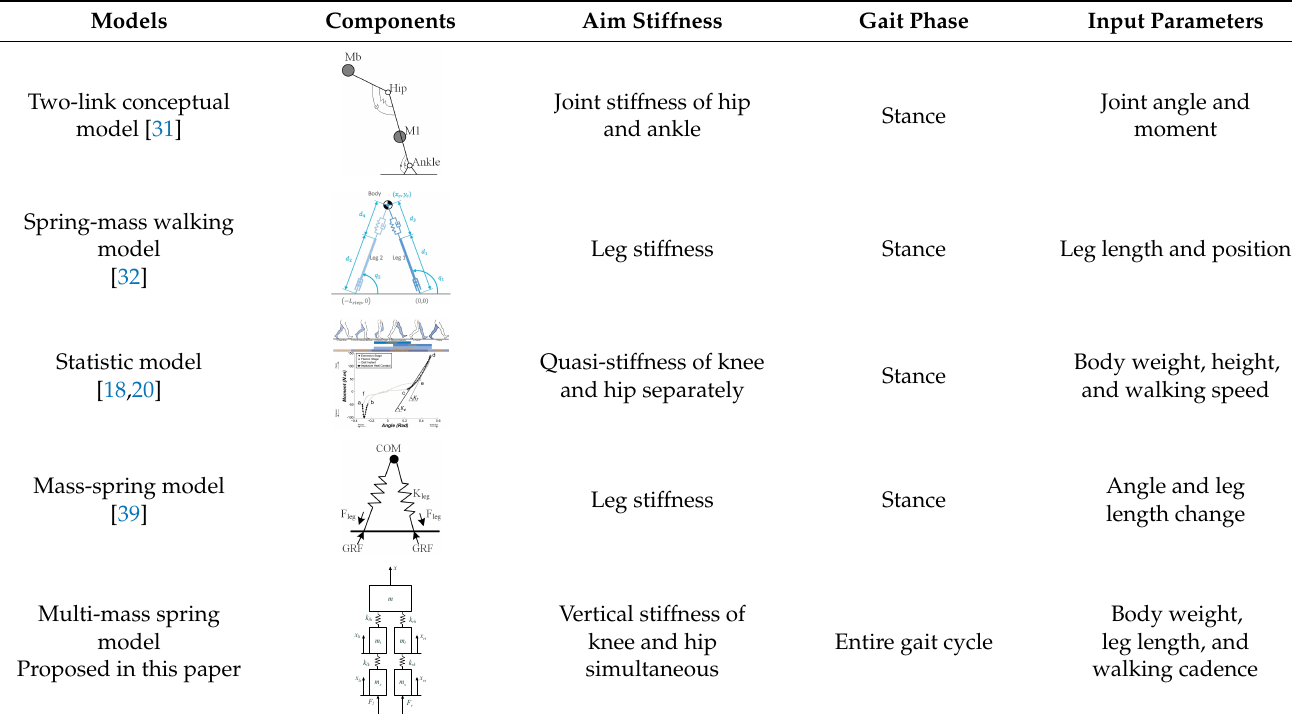
Table 3. The comparison between the typical and proposed dynamic models for stiffness calculation.